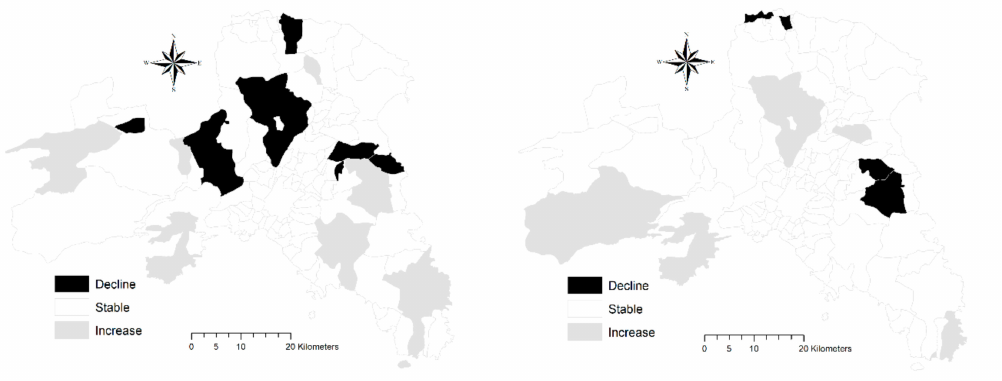
Figure 6. Changes over time in the absolute number of settlements in the study area between the 1990s and the 2000s ( left ) and between the 2000s and the 2010s ( right